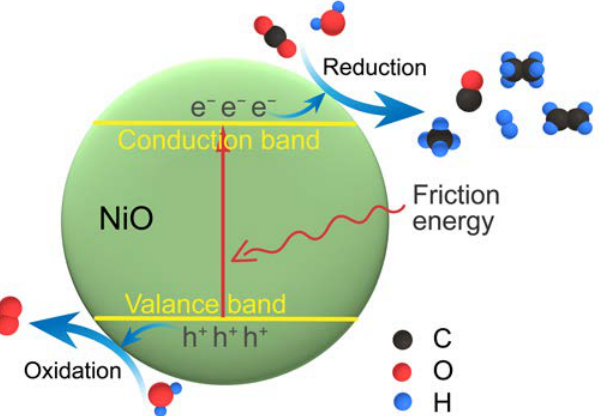
Figure 7. Schematic illustration for the catalytic production of flammable gases by a NiO particle via friction in water.